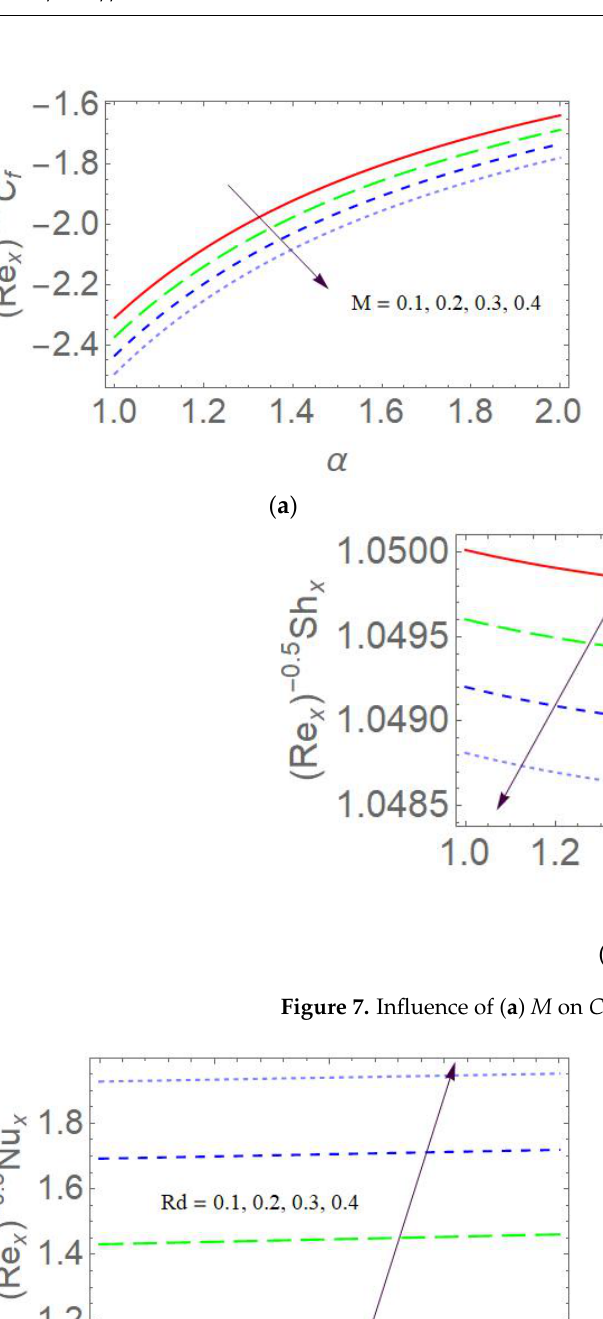
− 0.5 and ( b ) Rd on Sh x ( Re x )